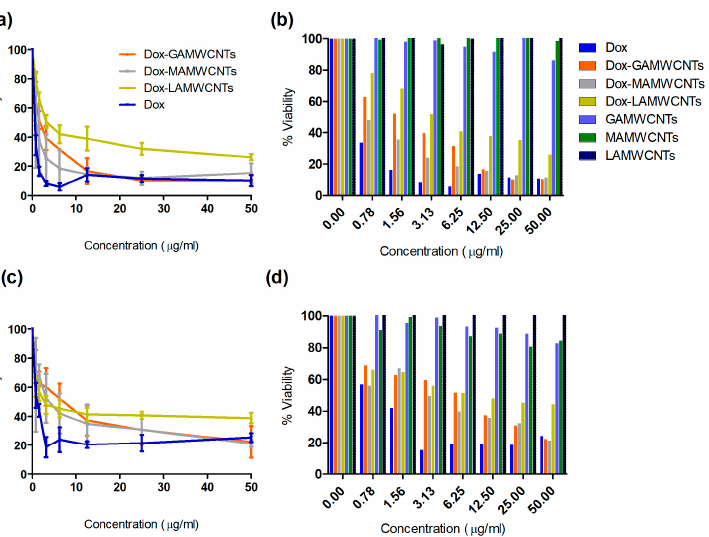
Figure 9. Graph showing the cumulative % drug release of Dox-loaded MWCNTs formulation at pH 7.4 and pH 5.0. The experiments were performed in triplicate.